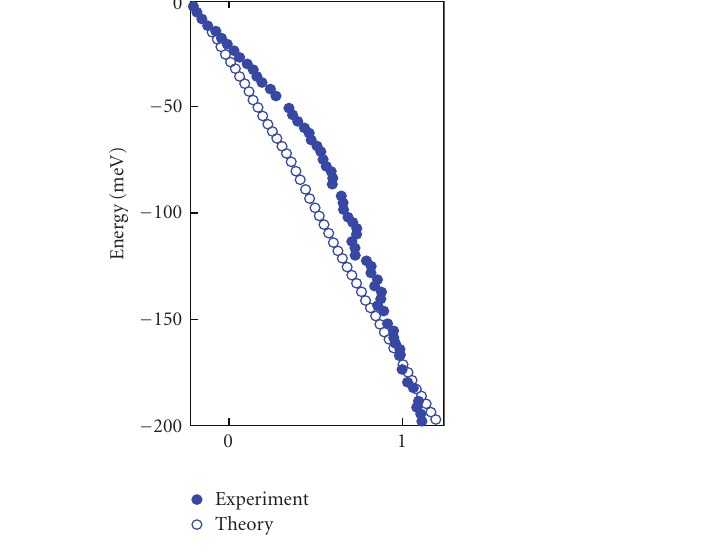
Figure 17: Comparison between the quasi particle dispersion relations obtained from the peaks of the photoemission spectra and calculations of [42], including the renormalization due to the electron-phonon interaction in La 1 . 85 Sr 0 . 15 CuO 4 .